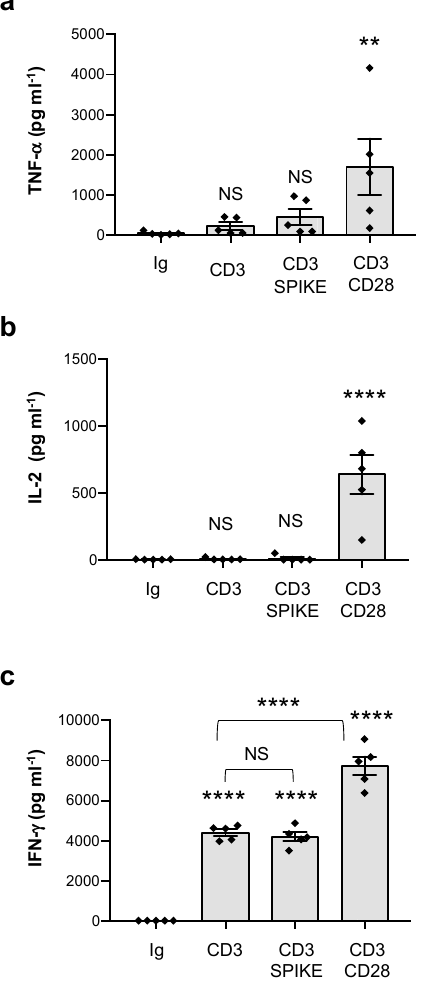
Figure 3. SARS-CoV-2 spike does not co-stimulate inflammatory cytokine production in anti-CD3 activated CD4 + T cells. ( a – c ) Peripheral blood CD4 + T cells from HD (n = 5) were cultured for 24 h with isotype control Abs (Ig) or 2 µ g mL − 1 crosslinked anti-CD3 Abs (UCHT1) or anti-CD3 plus anti-CD28 (CD28.2) Abs or anti-CD3 Abs plus SARS-CoV-2 spike. TNF- α ( a ), IL-2 ( b ) and IFN- γ ( c ) secretions in culture supernatant were measured by ELISA. Data show the mean ± SEM. Statistical significance was calculated by comparing each condition with isotype control Abs (Ig) or between conditions indicated by the arcs by one-way ANOVA. (**) p < 0.01, (****) p < 0.0001. NS = not